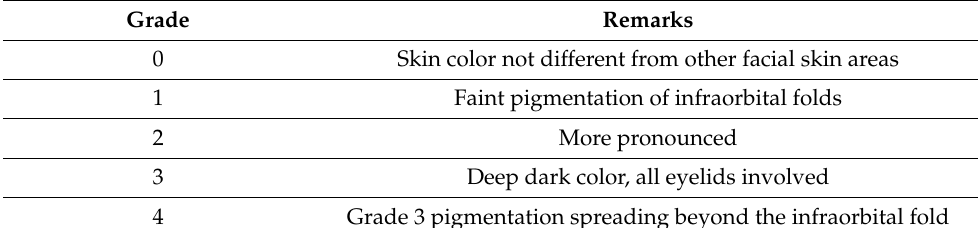
Table 1. Classification of periorbital hyperpigmentation (POH) according to Ranu et al. (2011) [11]. • Patients show a curved band of brownish to black skin pigmentation on lower eyelids Constitutional approximating the shape of the orbital rim with frequent involvement of upper eyelids. Here, irregular patches of brownish or gray pigmentation can be found on the upper, lower, or Post-inflammatory both eyelids with lichenification, and eczematous lesions in the surrounding areas. Vascular bluish discoloration of the lower eyelid and visible bluish veins. Shadow effect